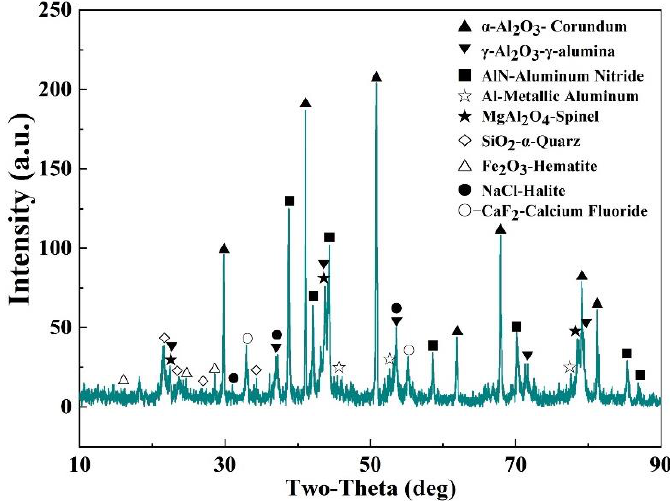
Figure 2. XRD pattern of the SAD sample.